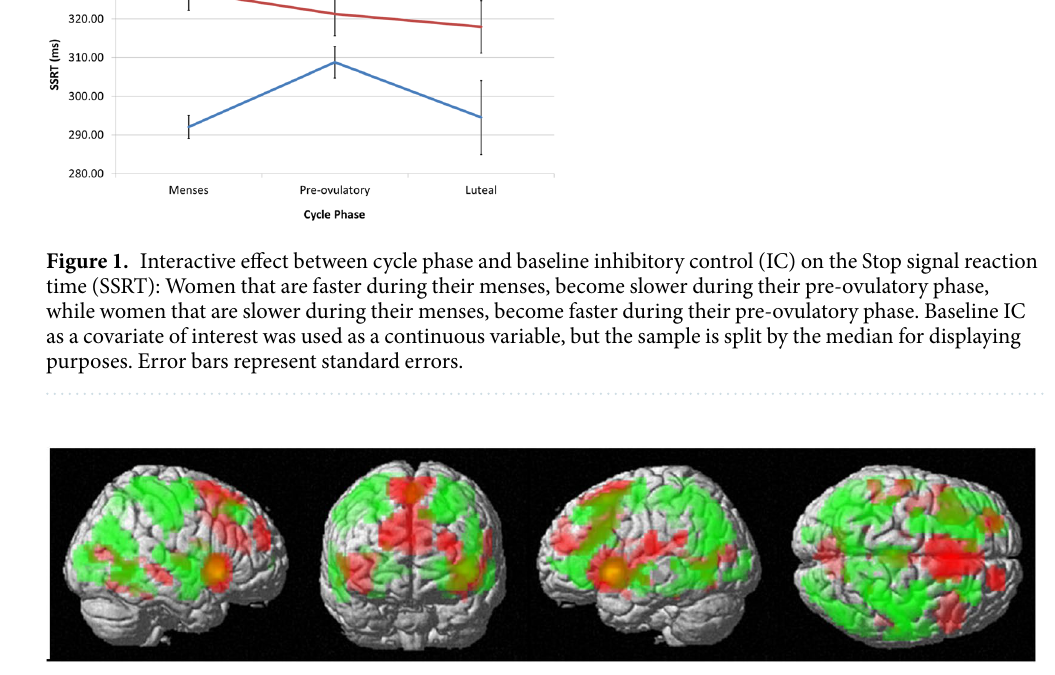
Figure 2. Overall activation during the Stop Signal Task: BOLD-response for successfully inhibited Stop trials vs. non-inhibited Stop trials in green. BOLD-response for non- inhibited Stop trials vs. successfully Stop trials in red. Uncorrected p < 0.001, pFWE < 0.05 at cluster level, and extent threshold of k = 40